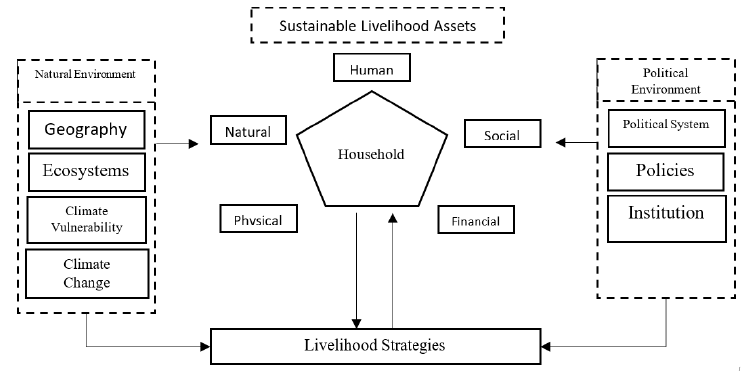
Figure 1. Sustainable livelihoods approach (DFID 2008).